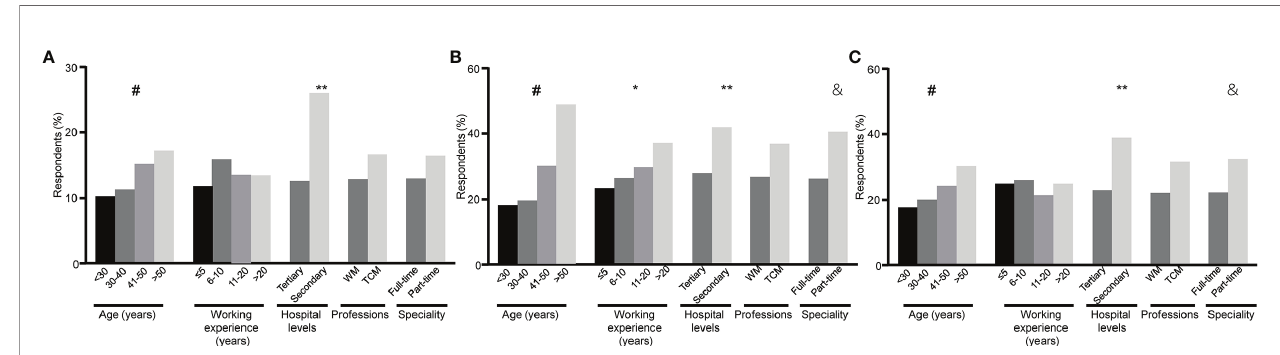
FIGURE 4 | Strati fi ed analysis of respondents with misconception in diagnosing of psoriatic arthritis (PsA) by age of rheumatologists, working experience as rheumatologists, levels of hospitals, medical training system and speciality of respondents. The percentages of respondents who answered incorrectly ( “ Yes ” ) to the following questions are shown. (A) Do you think the diagnosis of PsA could be made once psoriasis patients presented arthralgia? (B) Do you think the diagnosis of PsA could be ruled out when patients with psoriasis had positive rheumatoid factors (RF) or anti-cyclic citrullinate peptide antibodies (ACPA)? (C) Do you think the elevation of erythrocyte sedimentation rate (ESR) or C-reactive protein (CRP) is a prerequisite for the diagnosis of PsA? # represents the percentages of respondents signi fi cantly differ among age groups (P < 0.01). * represents the percentages of respondents signi fi cantly differ among working experience groups (P < 0.01). ** represents the percentages of respondents signi fi cantly differ between levels of hospitals (P < 0.01). & represents the percentages of respondents signi fi cantly differ between speciality of rheumatologists (P < 0.01). WM, Western Medicine; TCM, Traditional Chinese